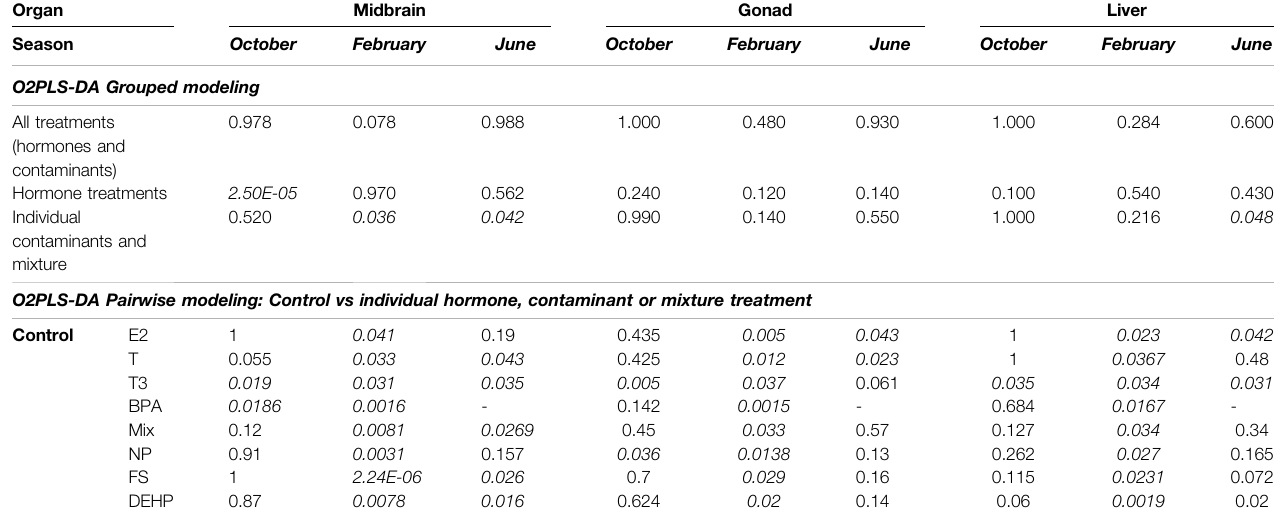
TABLE 1 | O2PLS-DA CV-ANOVA p values for grouped and pairwise models for comparison of hormone, contaminant and mixture treatments in midbrain, gonad and liver across seasons. Organ Midbrain